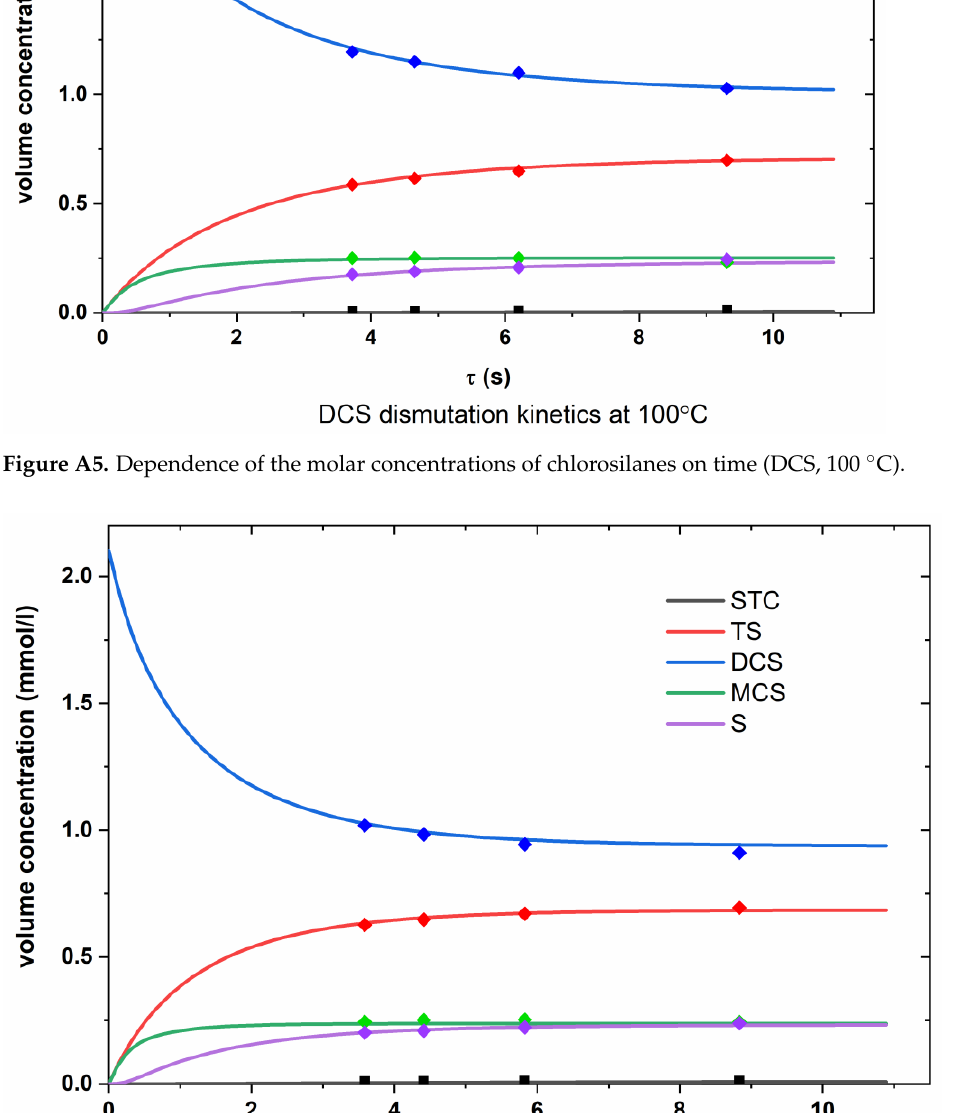
Figure A6. Dependence of the molar concentrations of chlorosilanes on time (DCS, 120 °C).